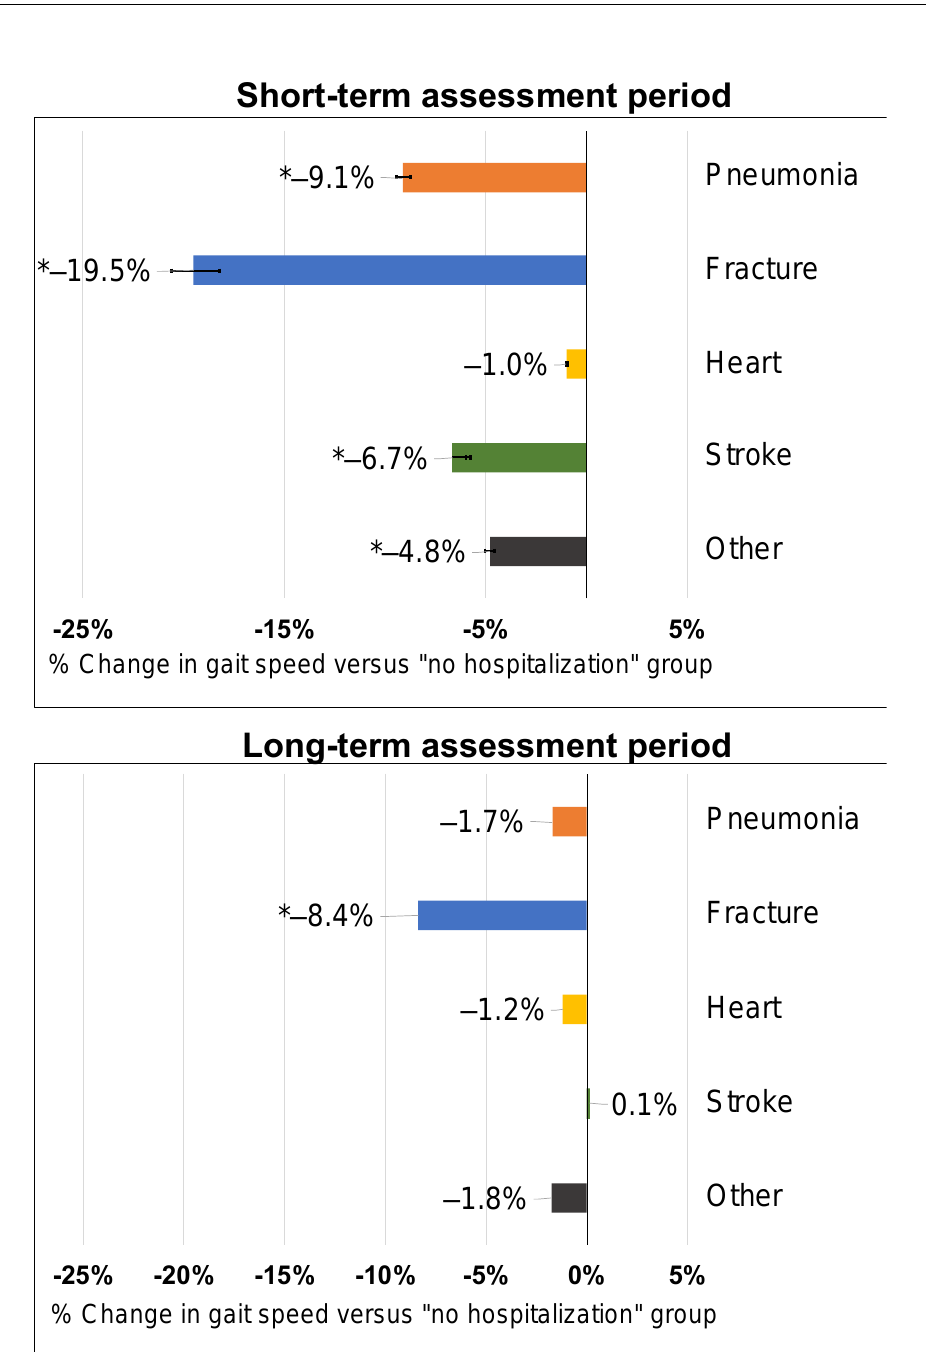
Figure 2. Adjusted percent change in short-term and long-term gait speed after an intervening hospitalization event. Labels indicate the point estimate and the p - value for the comparison to the “No event” group. Data labels represent point estimates. Asterisk (*) denotes statistical significance versus those without a hospitalization.